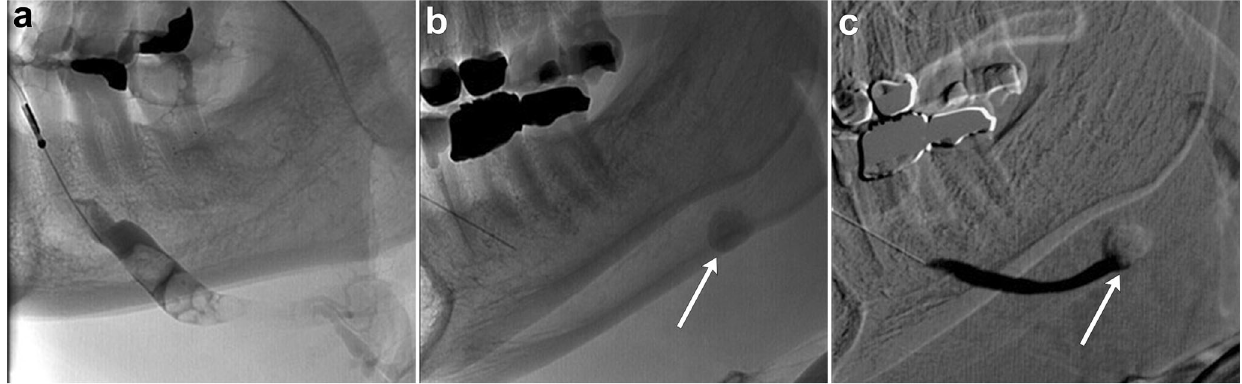
Fig. 11 Sialolithiasis. a Conventional sialogram demonstrates multiple filling defects within Wharton ’ s (submandibular) duct, consistent with sialoliths. b , c In another patient, pre- and post-contrast injection